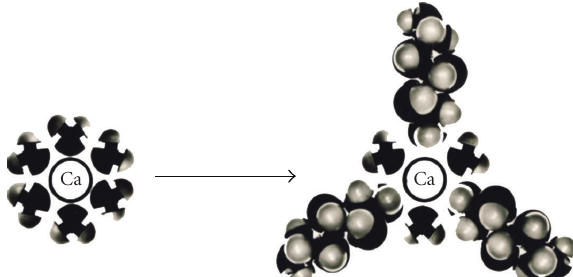
Figure 3: A simplified presentation of the competition between water and xylitol molecules for Ca, assumed to play a role in environments involving whole-mouth saliva and plaque fluid. Here, Ca has interacted with six water molecules which constitute the primary hydration layer of the metal ion (the actual number of water molecules surrounding the spherical Ca ion may vary from 4 to 12). The resulting new hydration layer consists of water molecules and xylitol molecules. This leads to stabilization of the salivary Ca phosphate systems [14, 18]. Reproduced with permission [14].